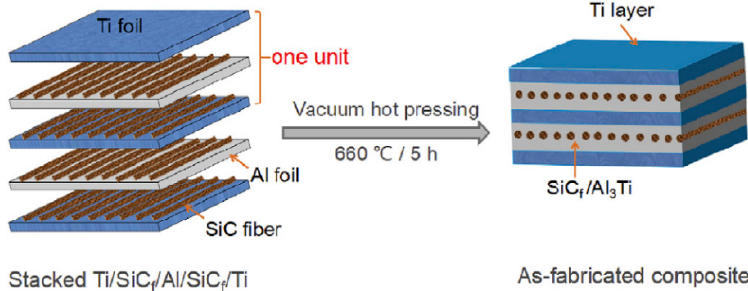
Figure 4. Schematic illustration of the fabrication process of Ti-(SiC f /Al 3 Ti) laminated